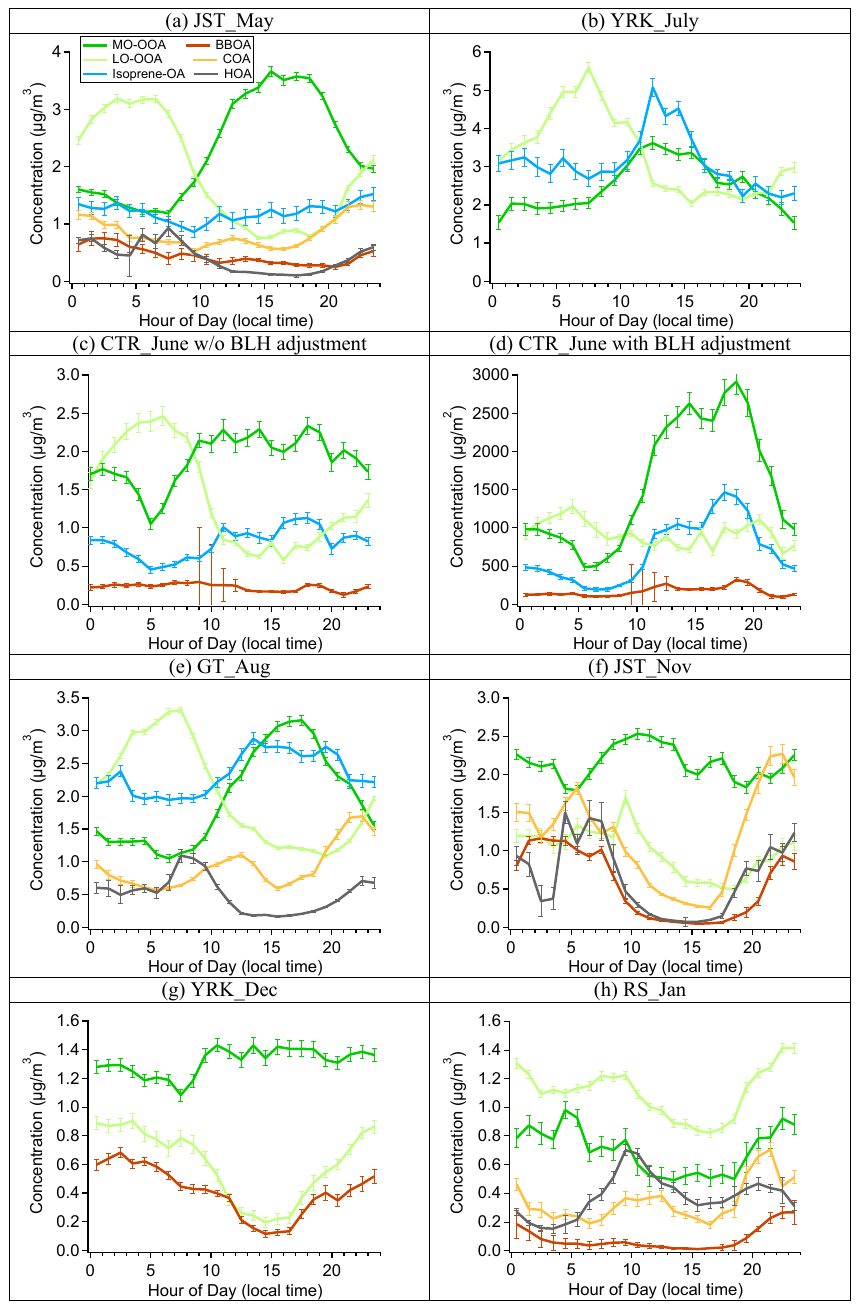
Figure 5. Diurnal profiles of OA factors resolved from PMF analysis on organic mass spectra. Panel (d) shows the diurnal profiles of OA factors after multiplying by the boundary layer height for the Centreville (CTR) site. The solid lines indicate the median concentration and the error bars indicate the standard